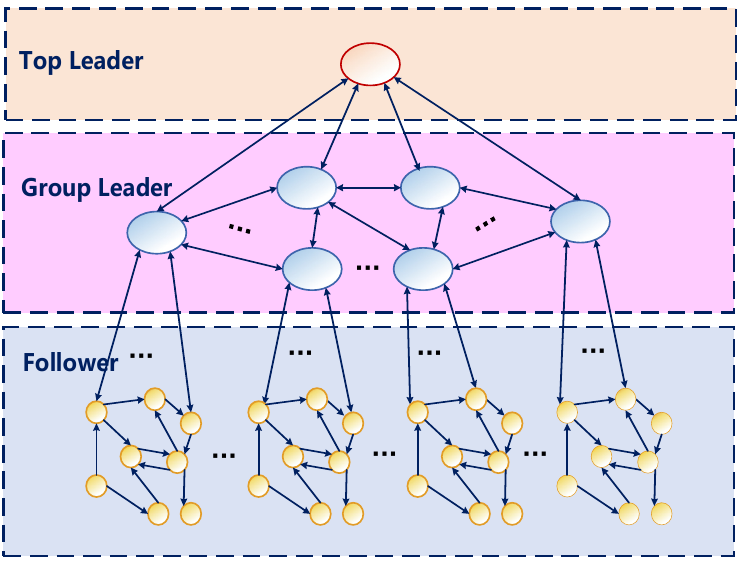
Figure 1. The hierarchical communication topology of UAV swarms with a distributed group.